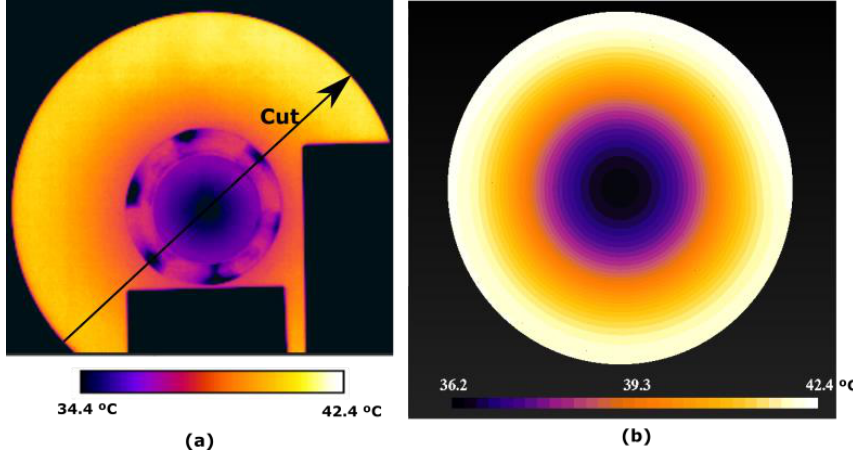
Figure 26. Temperatures obtained by CM in the parametric sections – Cut1 and Cut2 – from the centre of the disk to the periphery, at the instant of 245 s, see Figure 24b. The thermogram has been taken with the FLIR T425 thermal camera and the thermographic data has been obtained with the Fiji image analyser [32], see figure 24a.